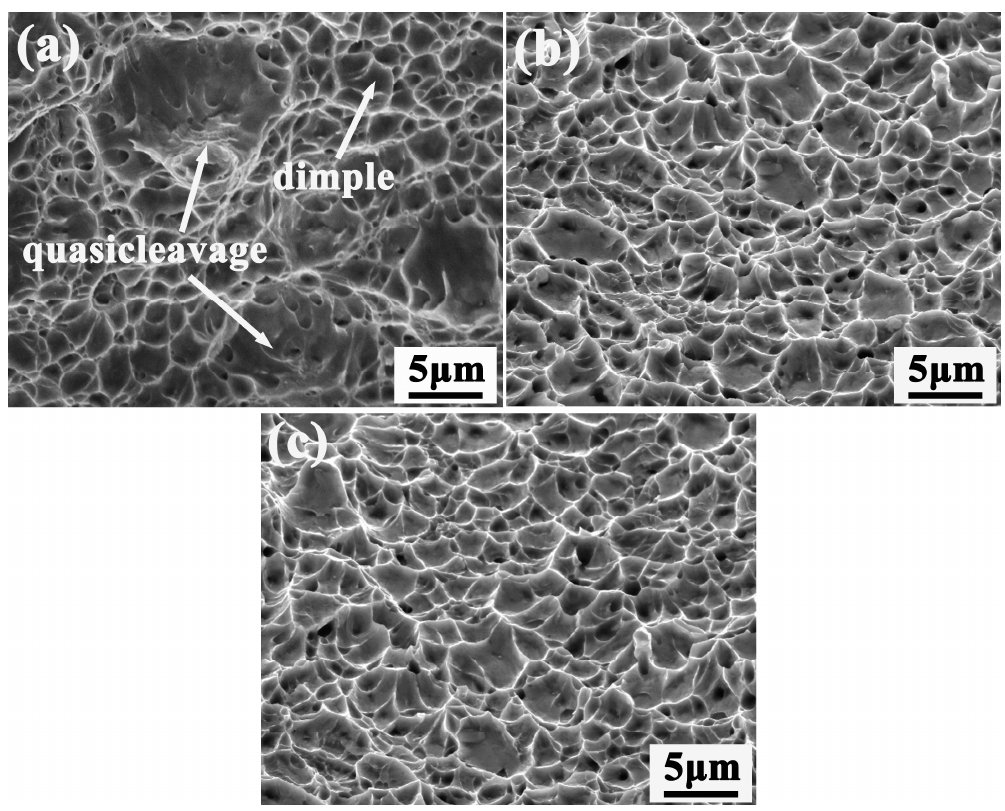
Figure 6. Fractographs of three tested steels with different compositions: ( a ) base, ( b ) Cr addition, and ( c ) Cr and Al addition.